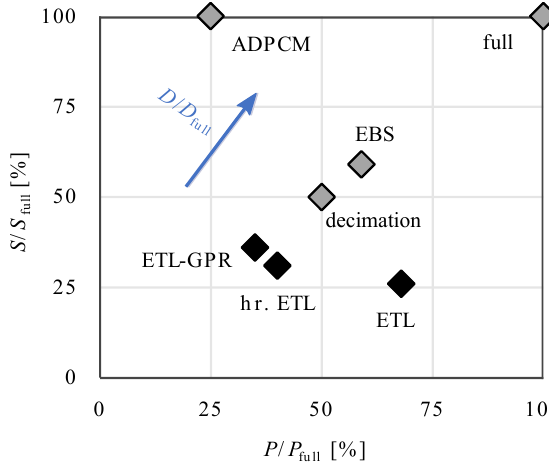
Figure 11. Number S of sampling instants with data transmission over the number P of transmitted data bits, i.e., the size of the ATT Payload, for seven different methods. The total number D of transmitted bits including the Bluetooth 5 overhead increases from the bottom left to the top right corner. Data from feet-mounted sensors during 4 min of variable gait is